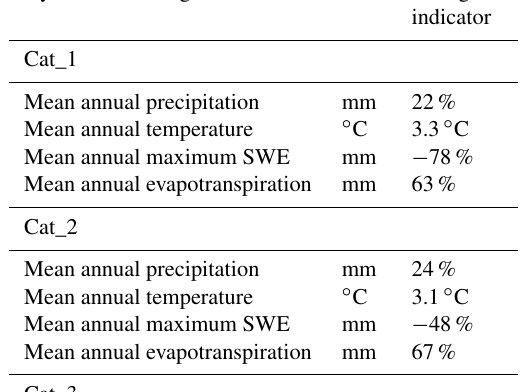
Table 4. Changes in mean annual temperature, precipitation, max- imum snow water equivalent (SWE), and evapotranspiration for all the study catchments using the bias-corrected NorESM1-M (r1i1p1) global climate model, WRF regional climate model and RCP8.5, and DDD